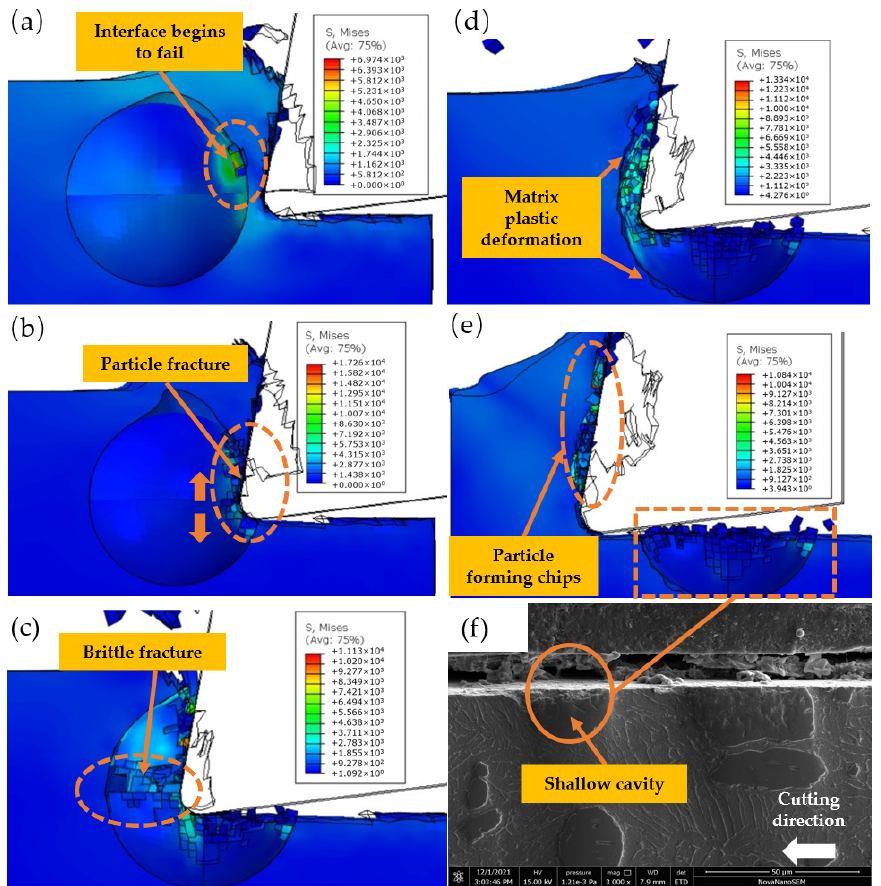
Figure 8. The simulated cutting process on the cutting path: ( a ) Cracking of TiC particles; ( b ) Tool contact with TiC particles; ( c ) Brittle Fracture of TiC Particles; ( d ) TC4 matrix damage; ( e ) Simulation results of brittle fracture of TiC particles; ( f ) Particle brittle fracture test results.